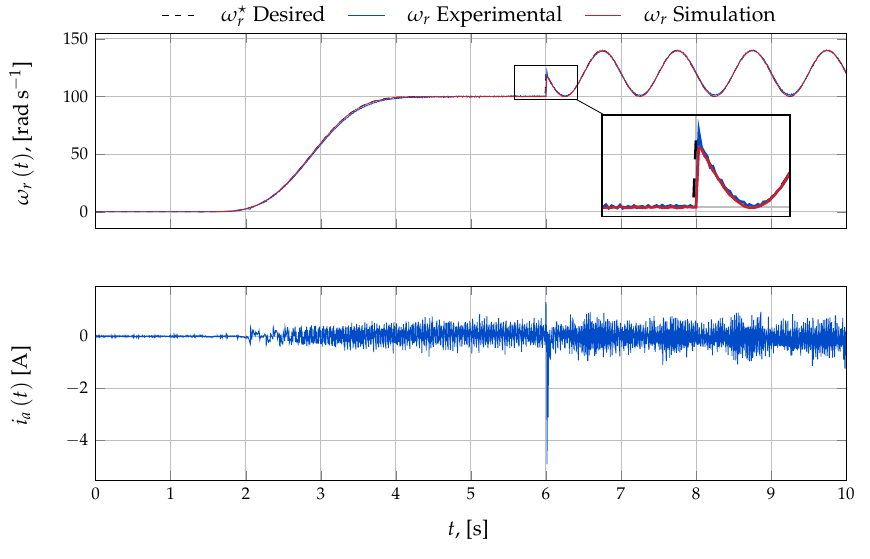
Figure 7. PI speed control results.